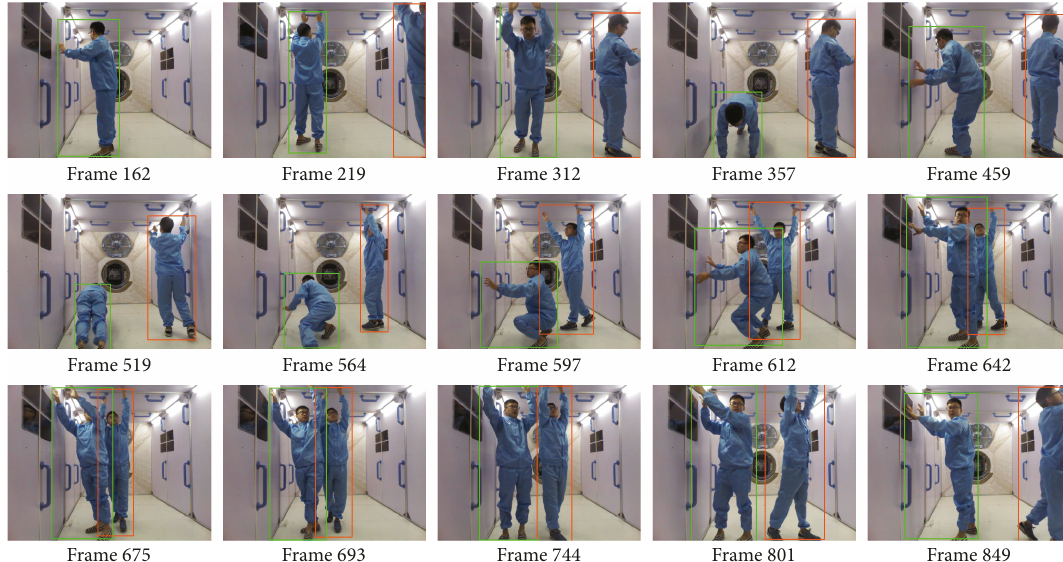
Figure 17: Tracking with other subject entering and moving very close to the target subject.